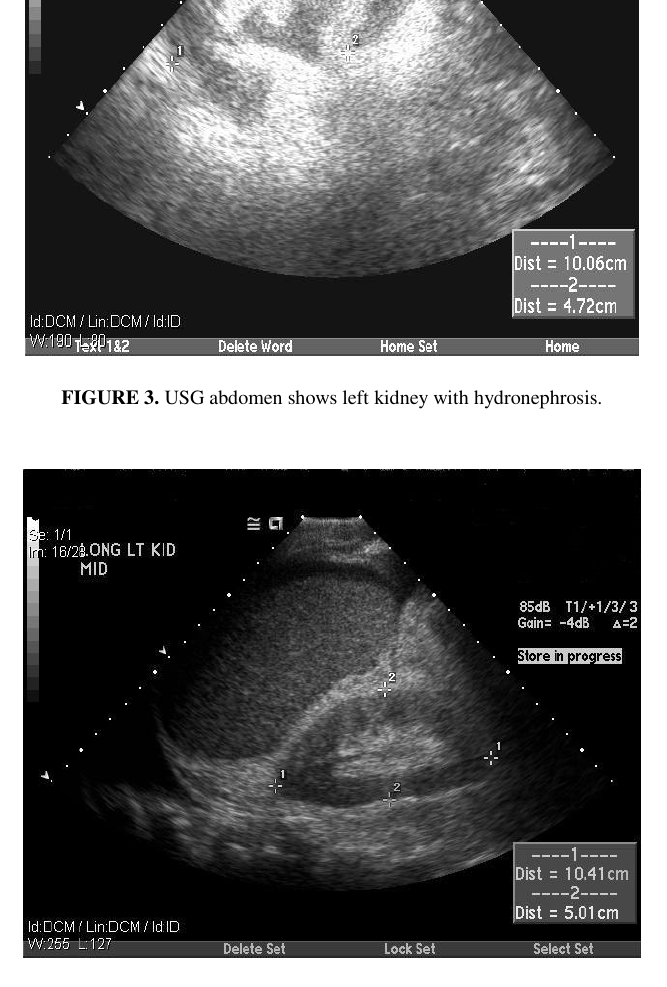
FIGURE 4. USG abdomen showing interval resolution of hydronephrosis in left